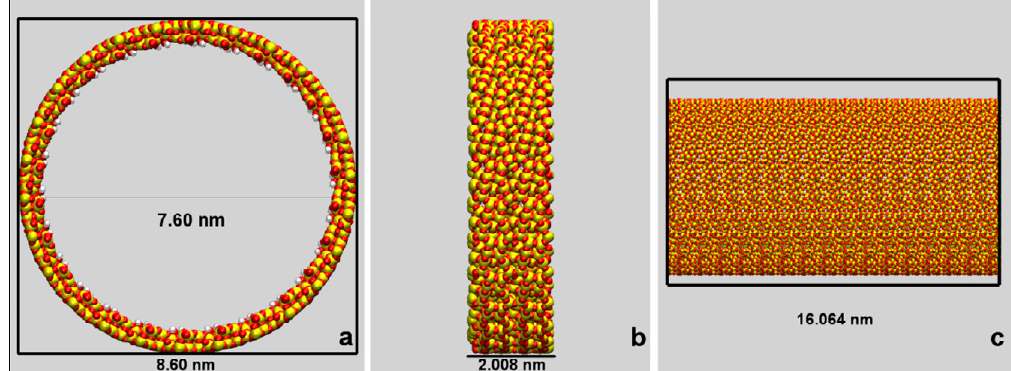
Figure 8. Graphical representations of the adopted cylindrical mesopore model. Atoms are represented as spheres with color codes: Si: yellow; O: red; H: white. Panel ( a ): circular section of the silica mesopore with an inner diameter of 7.60 nm and an external diameter of 8.60 nm. Panel ( b ): projection on the yz plane of the silica ring of 2.008 nm length. Panel ( c ) Projection on the yz plane of the cylindrical pore of 16.064 nm length. Atom colors: Si = yellow; O = red, H = white.